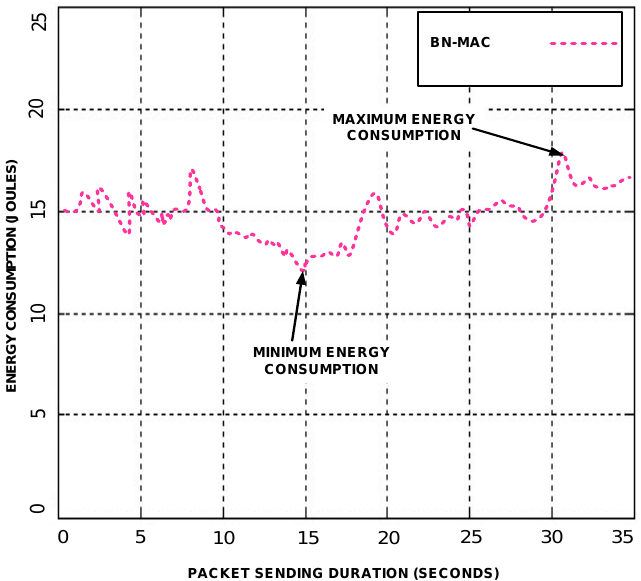
Figure 3. Packet sending duration versus energy